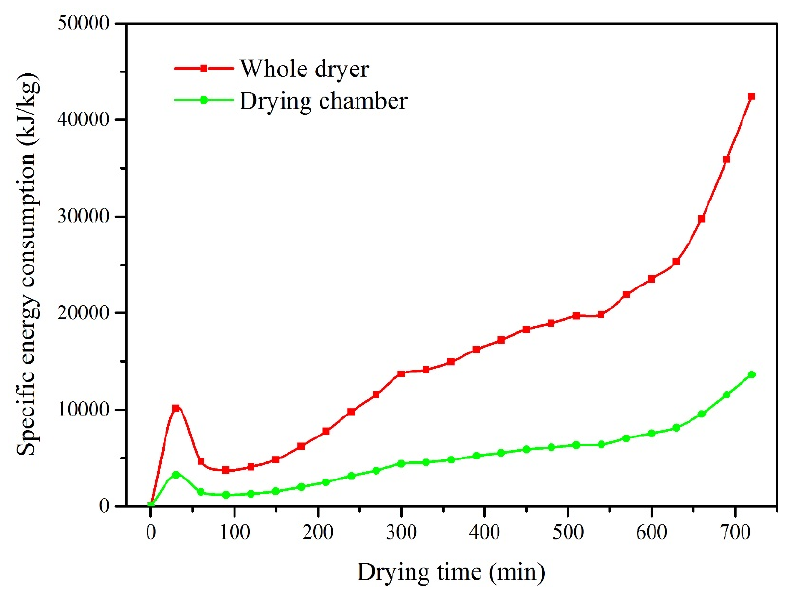
Figure 7. Assessment of overall energy consumption of ( a ) the entire drying system and ( b ) the counterflow drying chamber (DC).